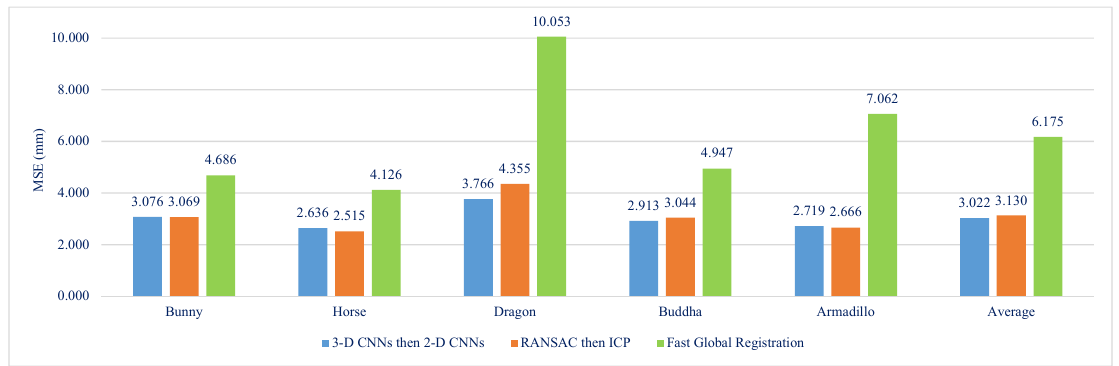
Figure 10. The comparison about average mean squared error (MSE) of 20 tested